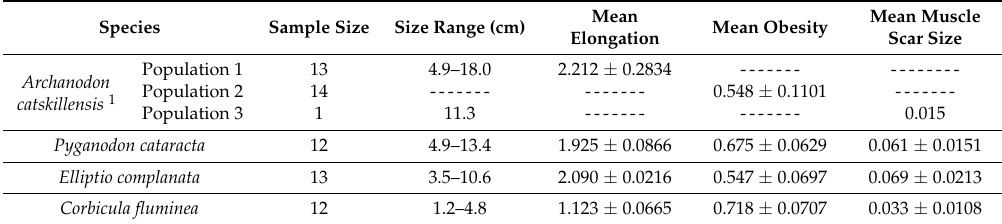
Table 2. Shell shape and muscle scar size for Archanodon catskillensis and three modern species, used here as burrowing proxies for A. catskillensis . Definitions for shell elongation, obesity and muscle scar size are given in Figure 6. Size range is based on maximum and minimum shell lengths for the specimen populations measured. Standard deviations around the mean are indicated where calculated. Dashed lines indicate no data available.